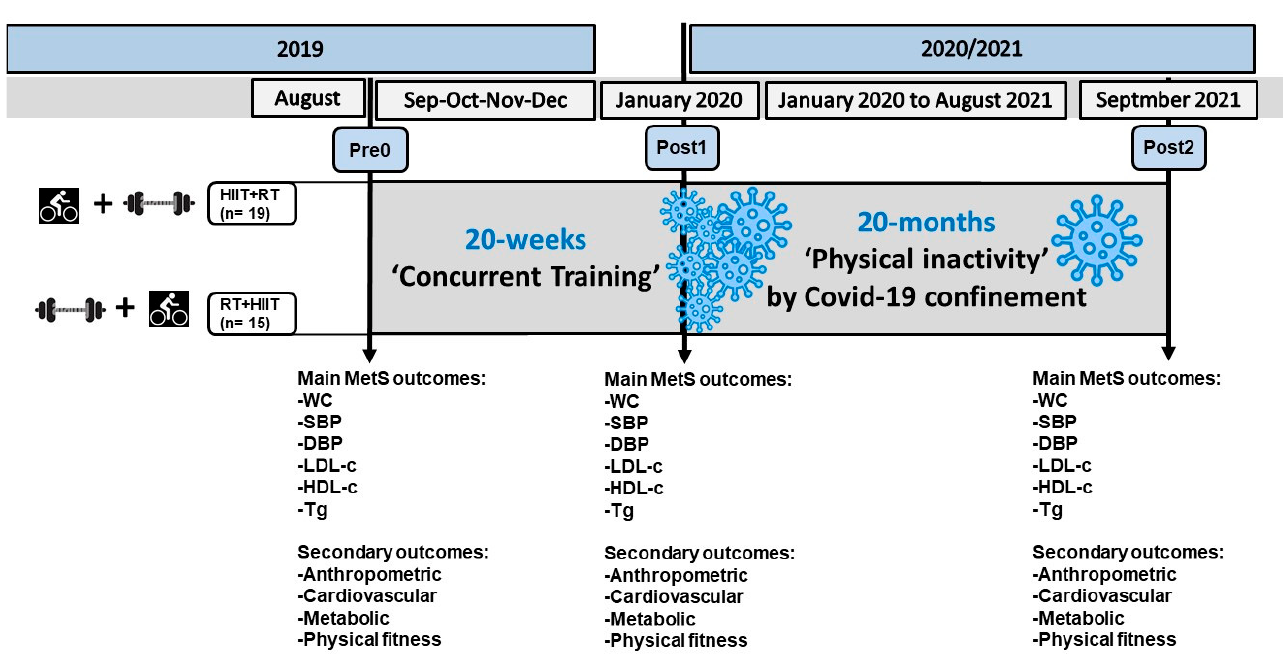
Figure 1. Study Figure 1. Study protocols.